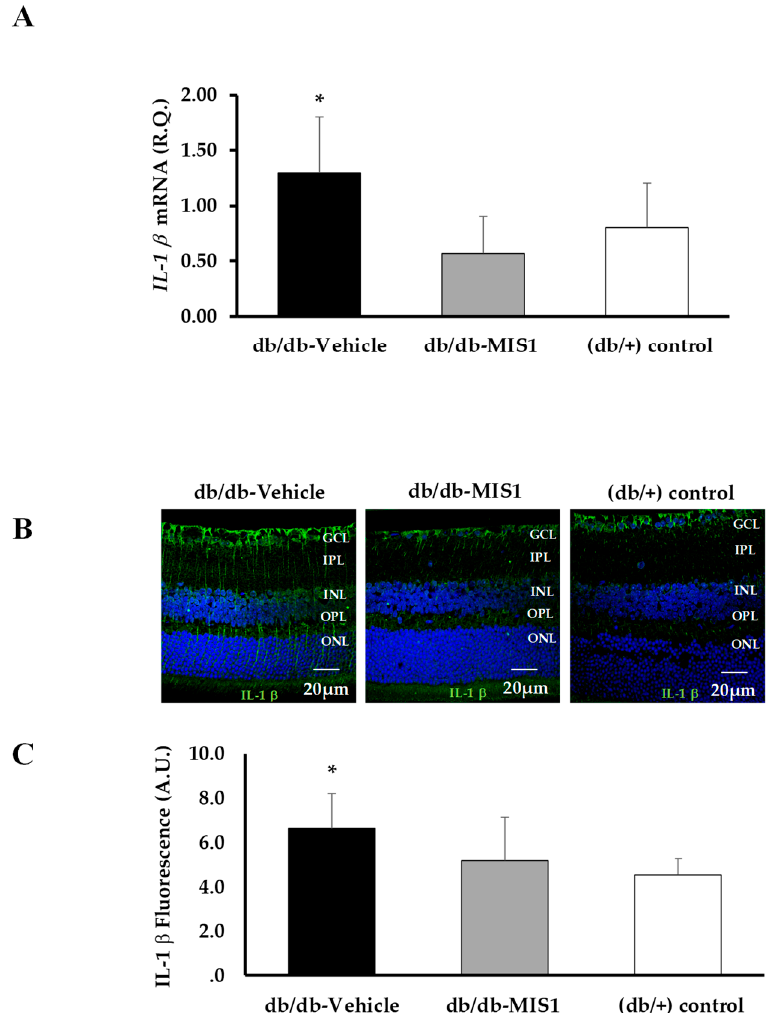
Figure 7. E ff ect of topical administration (eye drops) of SOCS1 peptidomimetic (MIS1) on IL-1 β . ( A ) Quantification of IL-1 β mRNA expression by RT-PCR. Results are mean ± SD. * p < 0.05 in comparison with the other groups. ( B ) IL-1 β immunofluorescent retinal images obtained by confocal immunofluorescence from a representative db / db mouse treated with vehicle, a db / db mouse treated with MIS1 and a non-diabetic (db /+ ) mouse. ( C ) Quantification of IL-1 β total fluorescence ( n = 7 retinas per group). AU: arbitrary units. Data are expressed as mean ± SD. ONL: outer nuclear layer; OPL: outer plexiform layer; INL: inner nuclear layer; IPL: inner plexiform layer; GCL: ganglion cell